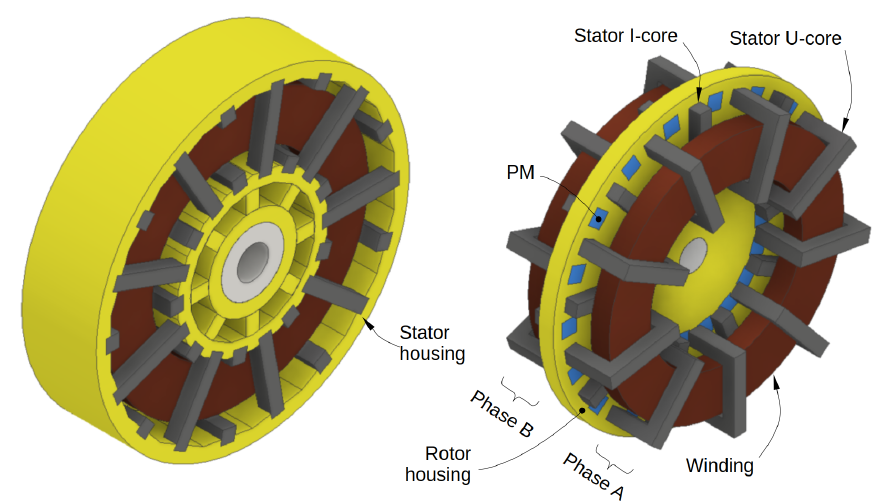
Figure 1. 3D model of the proposed transverse flux motor (TFM).